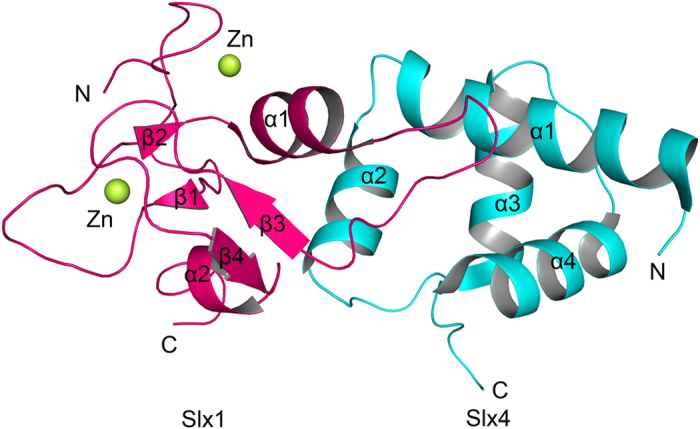
Cartoon representation of Slx1RING-Slx4CCD complex structure.Slx1RING and Slx4CCD are colored in pink and cyan, respectively. Green spheres indicate zinc ions. Loop1 and helix α1, two U-shaped loops that connect antiparallel β1-β2 and β3-β4 sheets contribute to the coordination of two zinc ions.